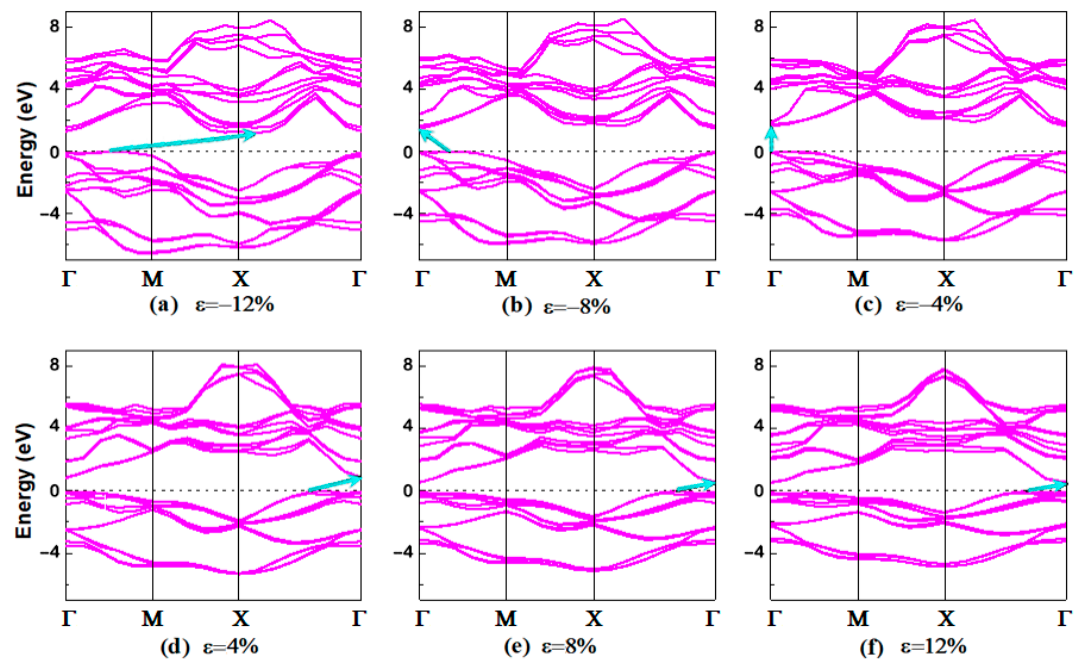
Figure 5. The band gaps of the T-AlP, V-AlP and T/V-AlP bilayers versus biaxial strain. The vertical dotted line corresponds to the unstressed condition. The biaxial strain step is 2% in our work.